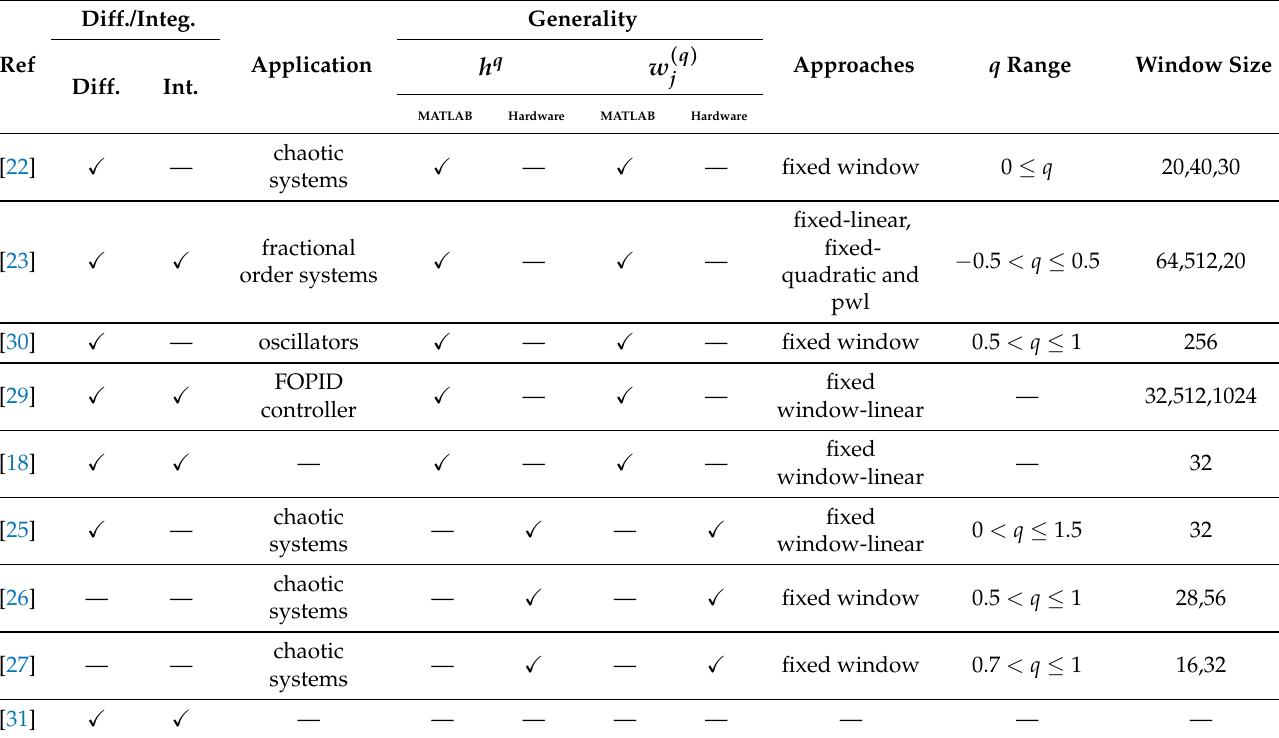
Table 1. Summary of different works on fractional-order integrator and differentiator